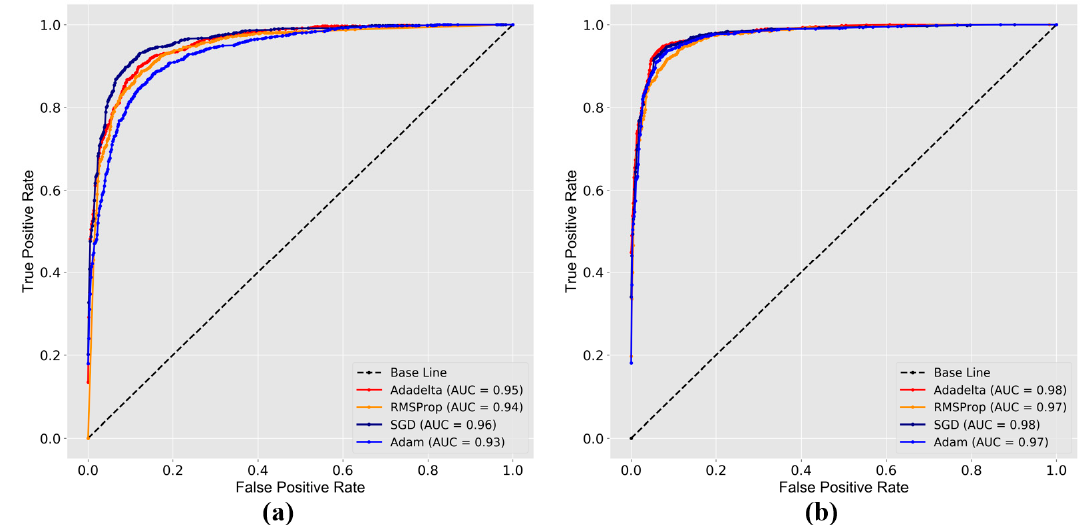
Figure 9. ROC curves for analyzing the behavior of different optimizers, generated by plotting predicted probability values (i.e., model’s confidence scores). ( a ) Performance of model 1 based on sigmoid activation. ( b ) Performance of model 2 based on softmax activation function.